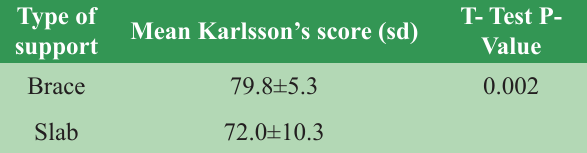
Table 4: Results of Karlsson score Type of